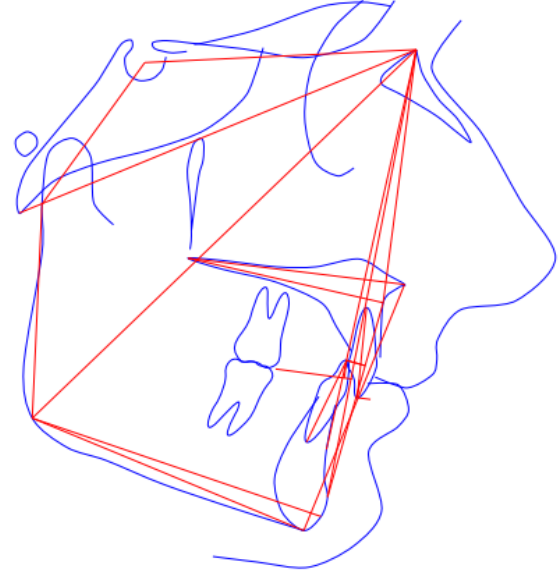
Figure 11. Pre-treatment cephalometric tracing.